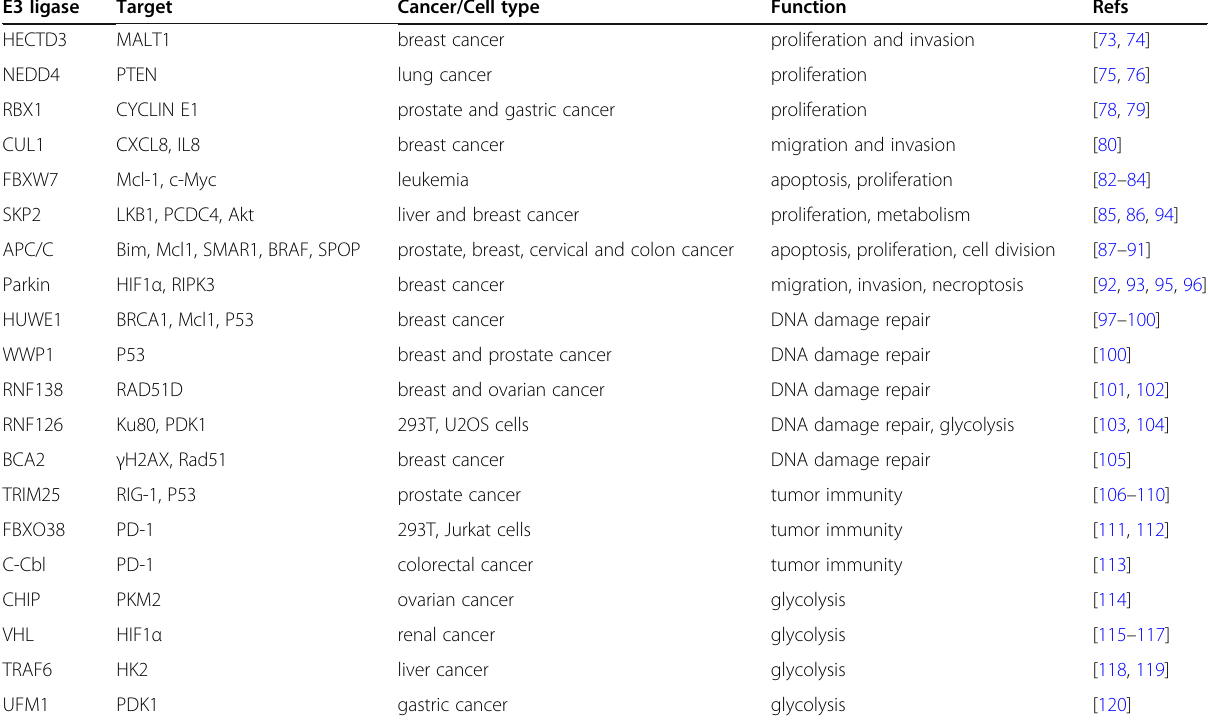
Table 1 Keys E3 ligases involve in the regulation of cancer progression E3